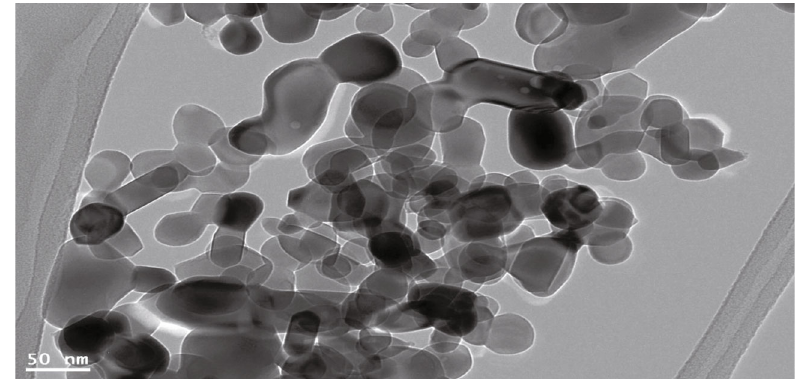
Figure 3: TEM images of Au-lectin conjugate nanoparticle prepared by laser ablation in deionized